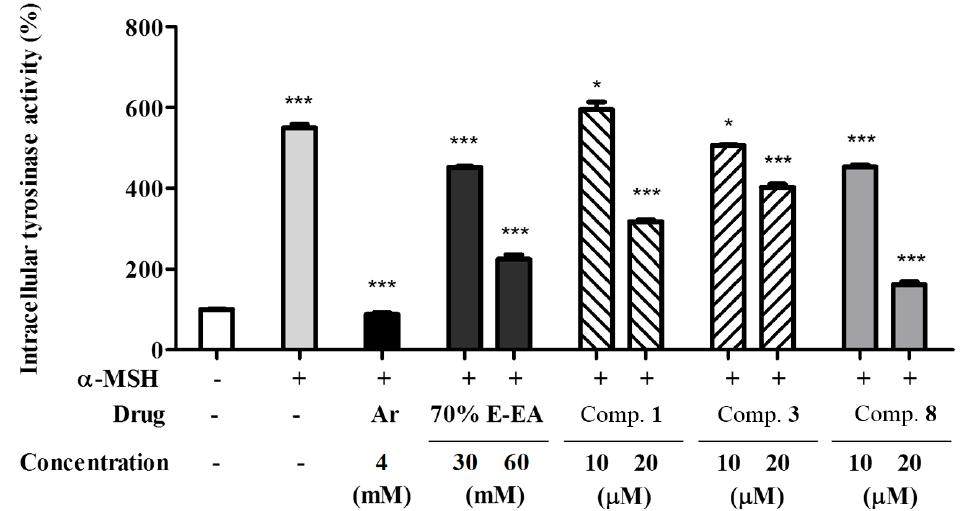
Figure 4. Effects on intracellular tyrosinase activity in murine B16-F10 cells; B16-F10 cells were pretreated with test samples for 2 h and then incubated with α -MSH (200 nM) for 72 h. The cell lysates (50 μ g) were dissolved in 100 mM phosphate buffer (pH 6.8) and treated with L-dopa (2 mg/mL) in a 96-well plate at 37 °C for 2 h. The production amount of dopachrome was measured by using an ELISA microplate reader at 490 nm. * p < 0.05 and *** p < 0.001 compared with the α -MSH-treated group.